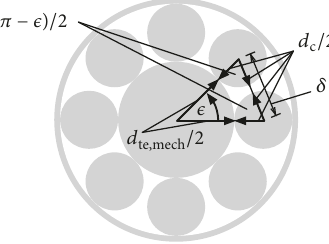
Figure 16: Angle and distance between the centers of two neighbor- ing electrical